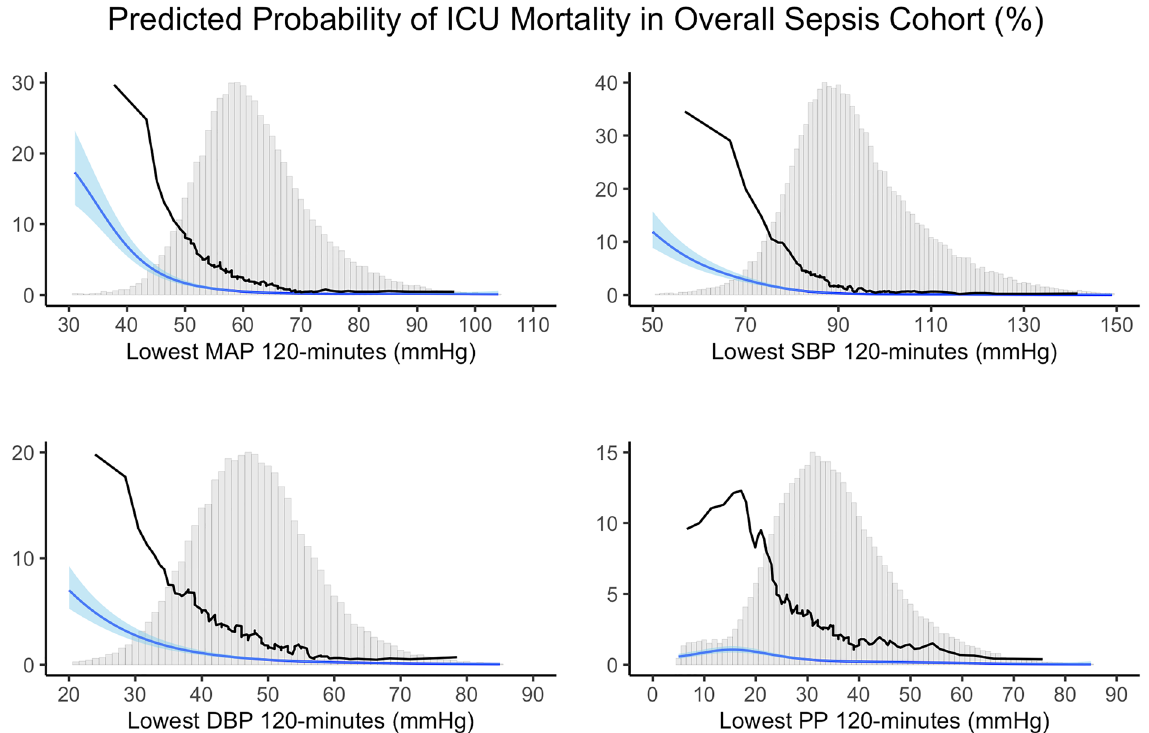
Fig. 1 Relationship between lowest blood pressure values and ICU mortality in overall sepsis